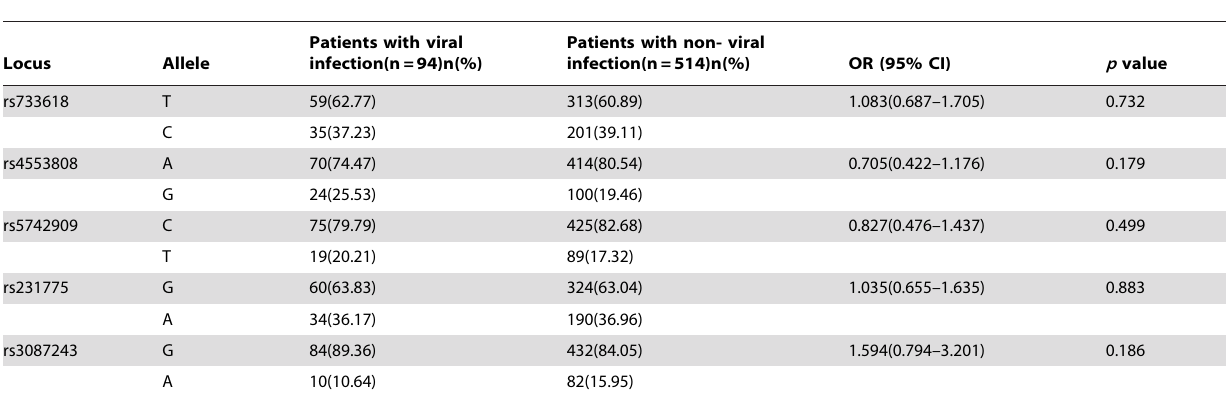
Table 5. The allele distribution of CTLA4 polymorphisms in patients with viral infection and non-viral infection.